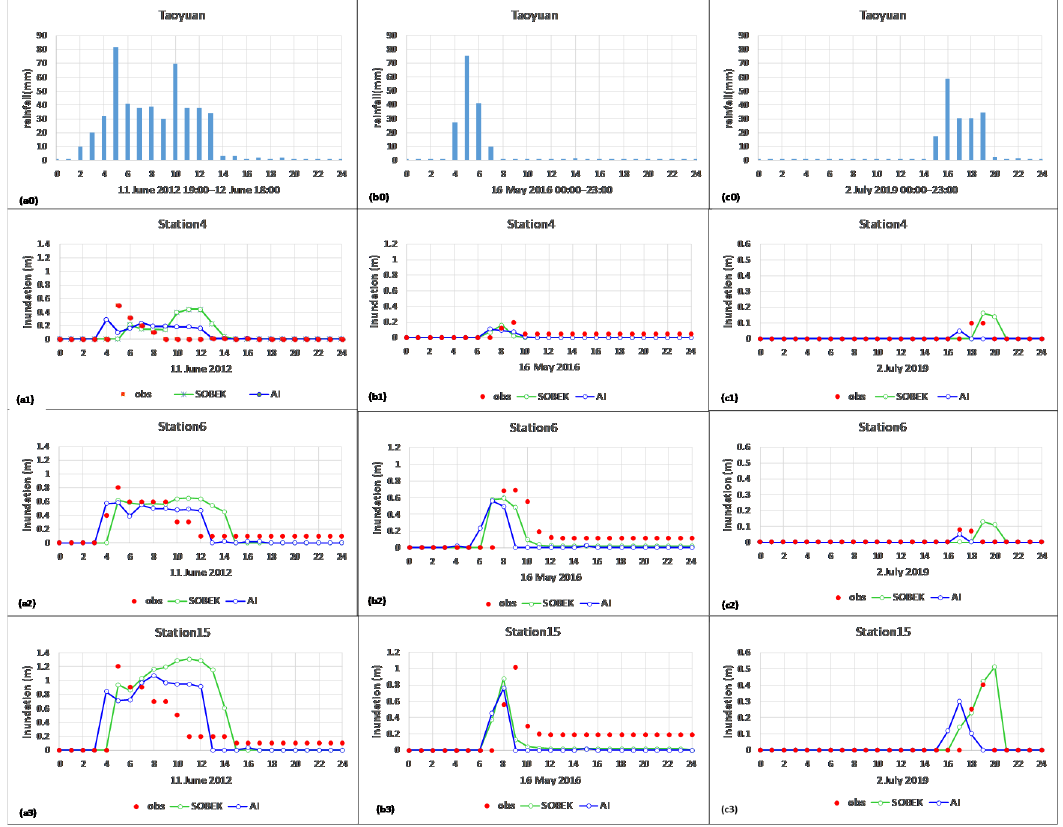
Figure 13. The inundated water depths of observed (in red), SOBEK model simulated (in green) and AI platform predicted (in blue) at monitoring stations 4, 6 and 15 over the study area during three rainfall events .